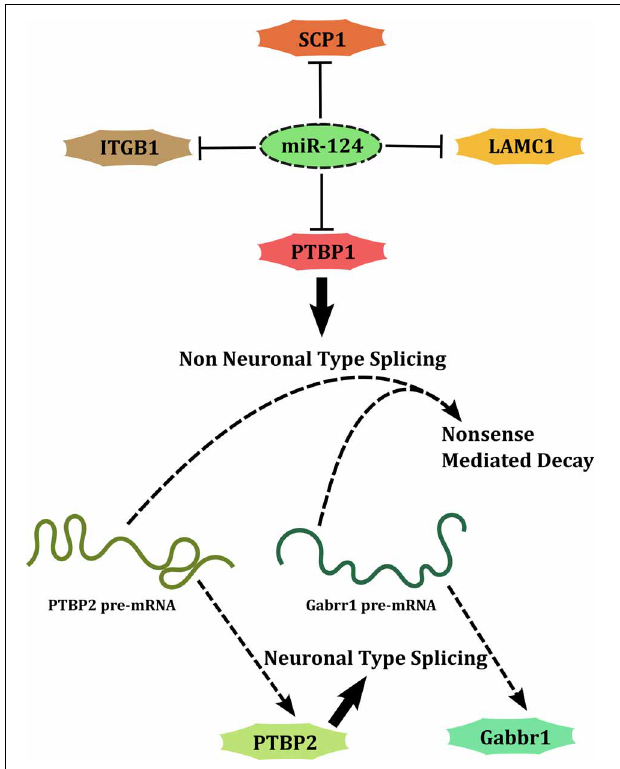
FIGURE 3 | miR-124 promotes neuronal differentiation by acting through a SIM. PTBP1 is downstream of miR-124 and is a part of another